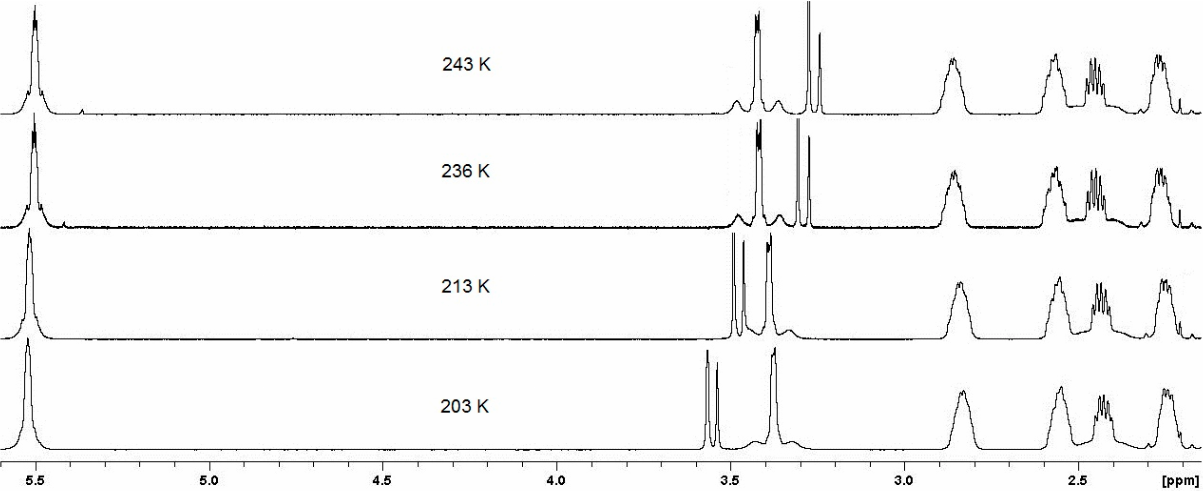
Figure 4. 1 H NMR spectra of [Pt(bpy)(cod)(Me)][SbF 6 ] recorded at 600 MHz in acetone-d 6 at various temperatures. The two singlet signals moving from about 3.3 to 3.55 ppm during cooling represent H 2 O and DHO, respectively, originating from the solvent